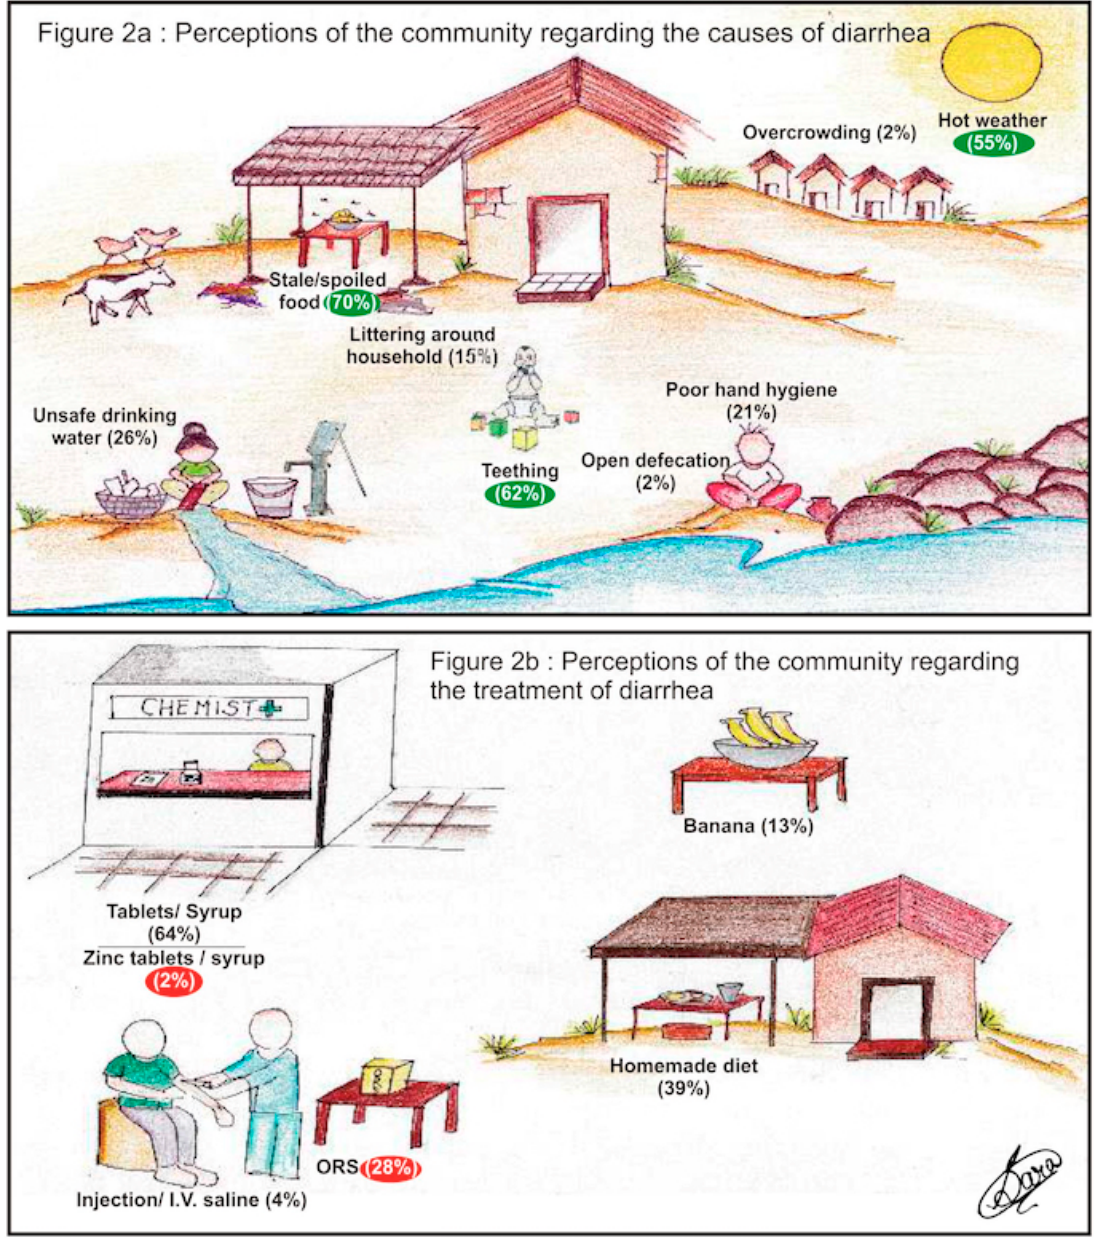
Figure 2. Perceptions of 1571 mothers regarding cause ( a ) and treatment of diarrhea ( b ) (Table S1 provides details in tabular form).